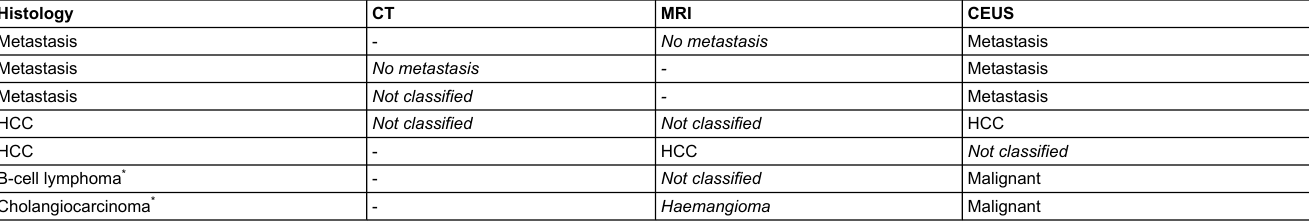
Table 5: Summary of all malignant lesions which were misclassified by imaging in comparison to histology.